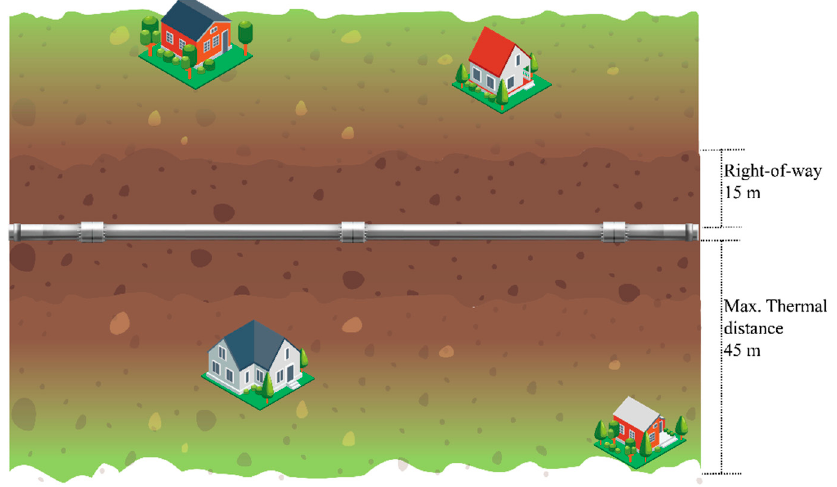
Figure 3. Location of people within the vicinity of the pipeline (adapted from [23]).